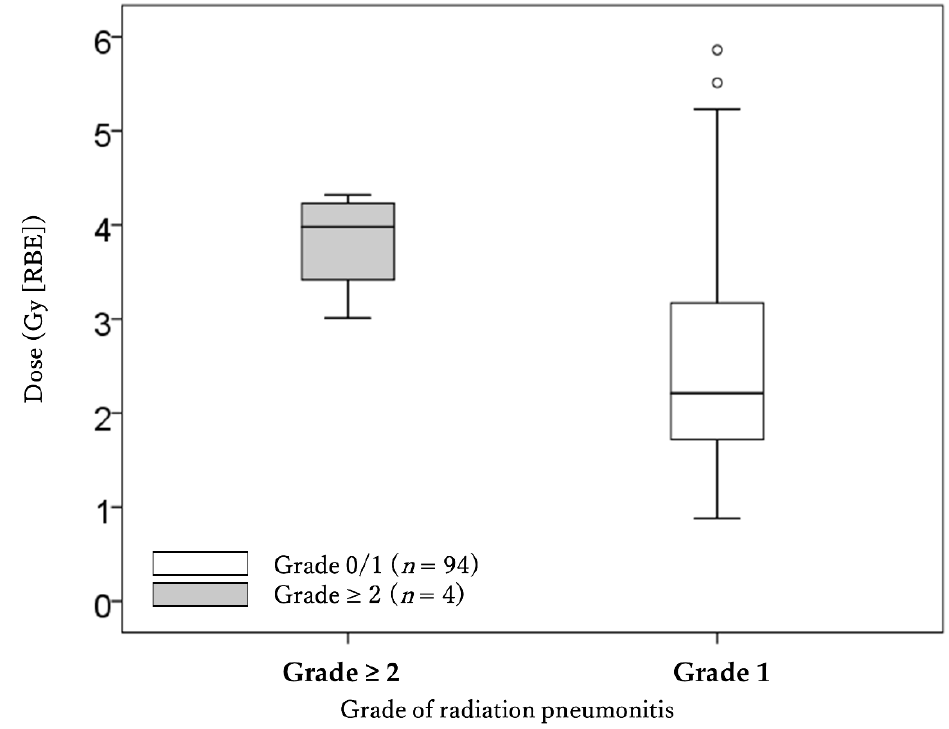
Figure 3. Comparison of the mean lung dose of all lungs between patients with grade 0–1 and grade 2–3 radiation pneumonitis. Abbreviation; RBE: relative biological effectiveness.